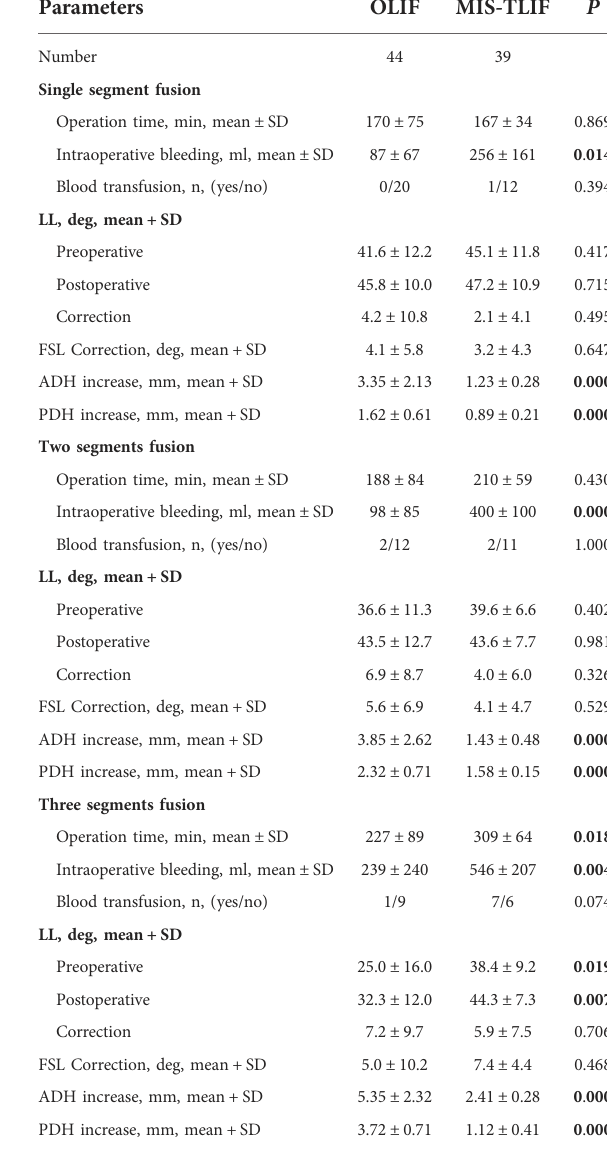
TABLE 2 The general comparison of OLIF and MIS-TLIF with different number of fused